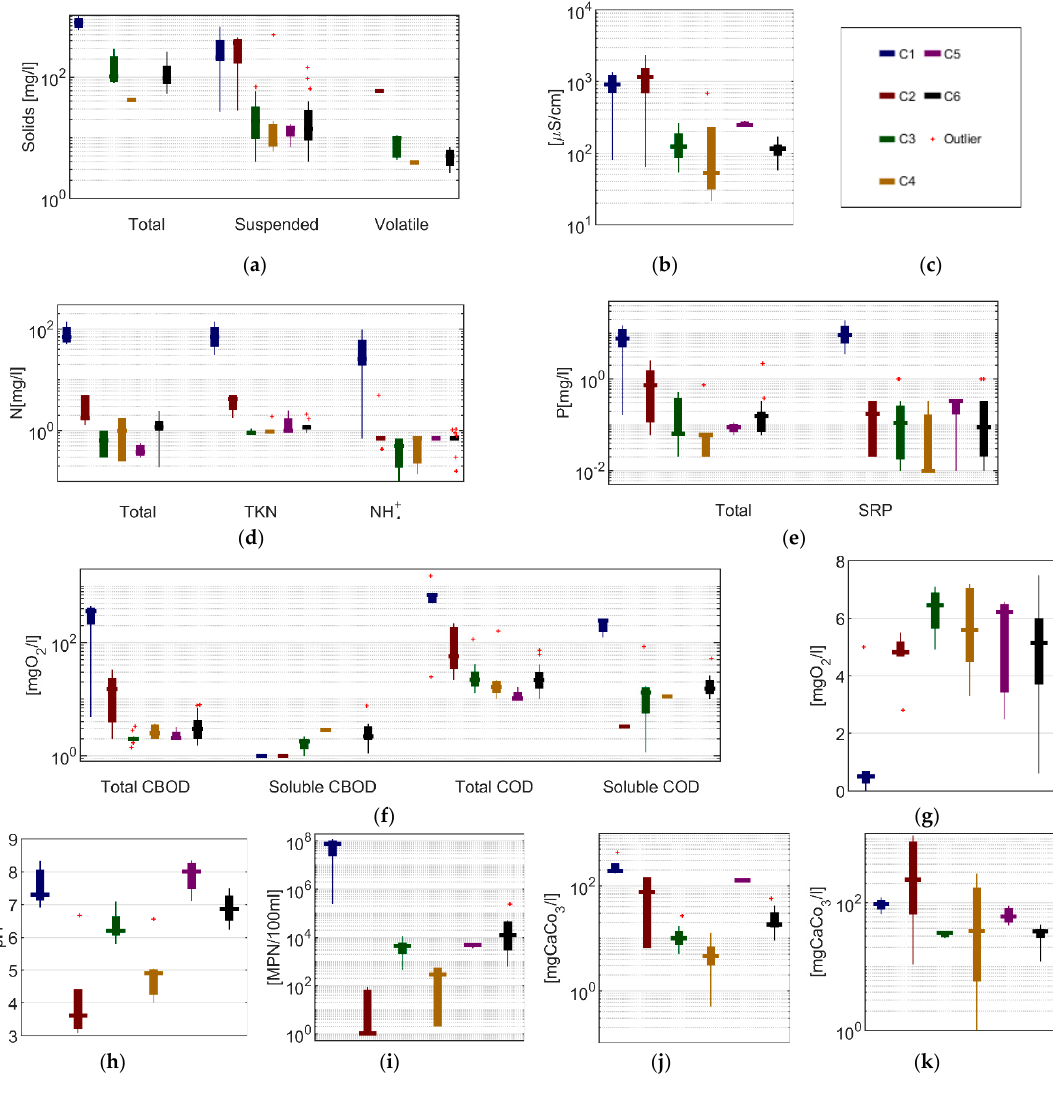
Figure 4. Spatial distribution of conventional water quality determinands: ( a ) solids; ( b ) EC; ( c ) legend; ( d ) nitrogen; ( e ) phosphorous; ( f ) oxygen-demanding constituents; ( g ) DO; ( h ) pH; ( i ) total coliforms; ( j ) total alkalinity; ( k ) total hardness.